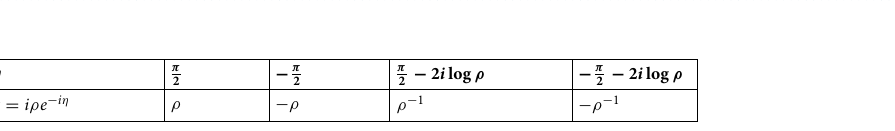
Table 3. Vertices of the rectangle in the η -plane and their corresponding vertices in the upper half of the < ρ − 1 z annulus ρ < | |